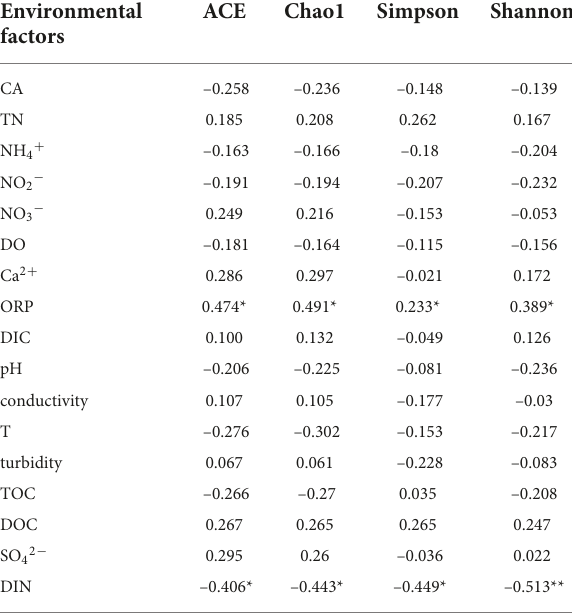
TABLE 5 Results of the correlation analysis between the community diversity of the cbbM gene-containing carbon-fixing bacteria and environmental factors in the Huixian karst